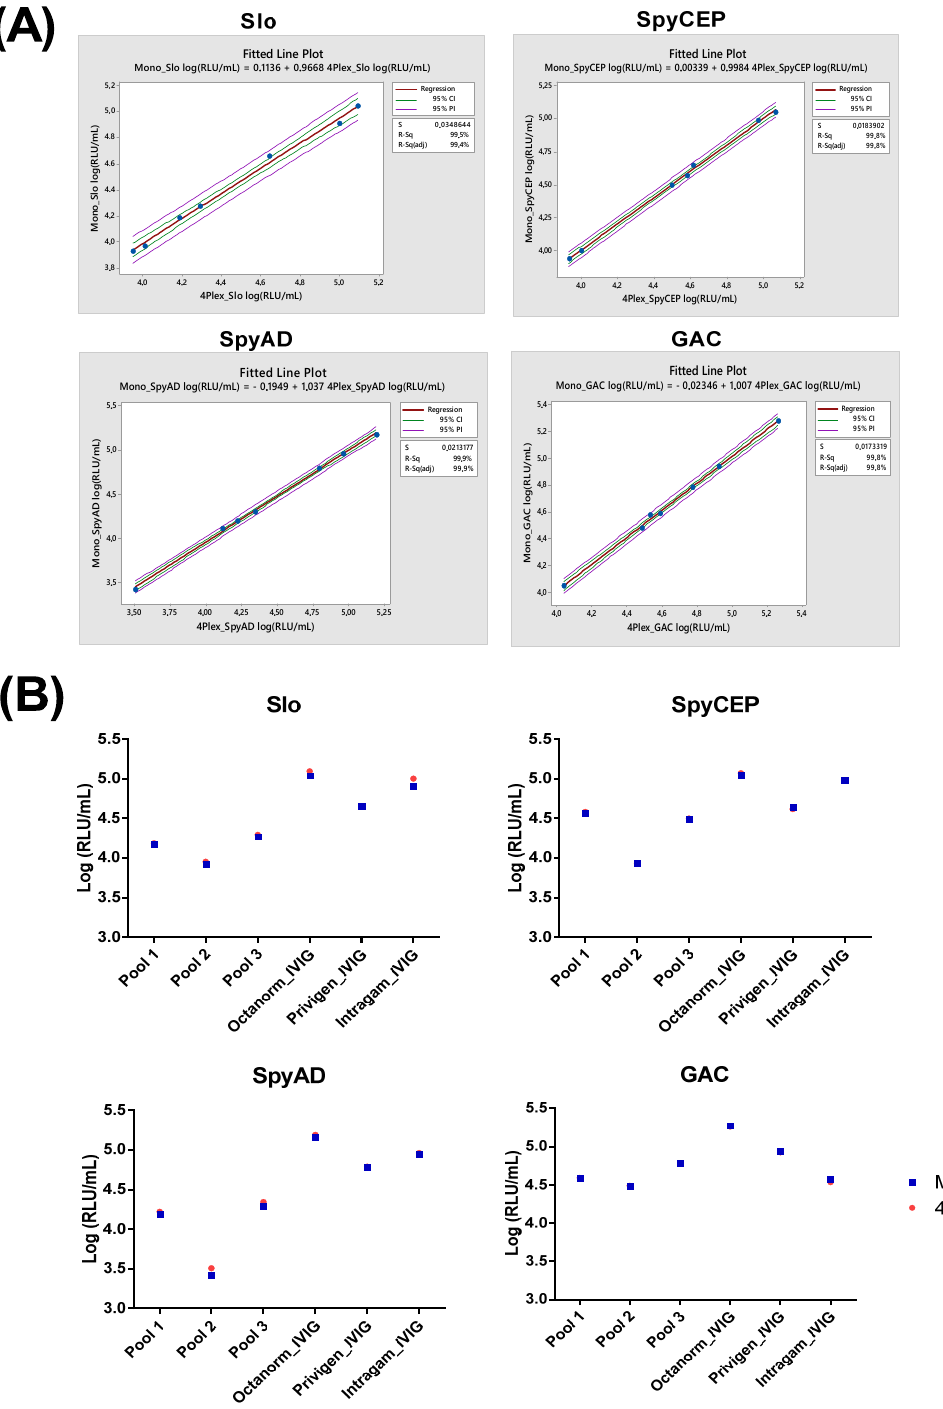
Figure 4. Assessment of IgG concentrations measured in monoplex and multiplex assay for four vaccine antigens. Figures demonstrate a single experiment comparing monoplex and multiplex to measure IgG. RLU/mL values were determined from the median RLU/mL from four dilutions of each sample in both monoplex and multiplex. ( A ) RLU/mL values were log 10 transformed prior to correlation analysis with linear regression. ( B ) Direct comparison of IgG concentrations measured in monoplex and multiplex assay for 4 vaccine antigens testing three different pools of human sera (pool 1, pool 2 and pool 3, respectively) and three different pools of commercial IVIG (Octanorm, Privigen and Intragam, respectively).